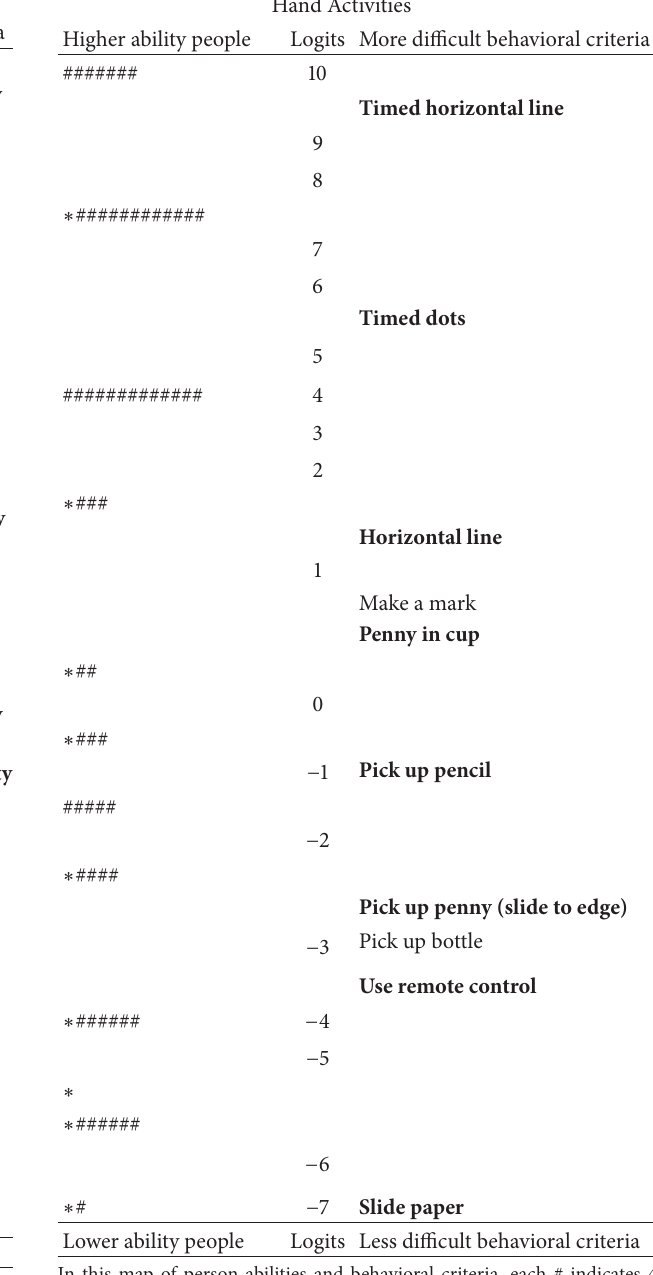
Table 3: Person-behavioral criteria map for hand movements. Hand movements